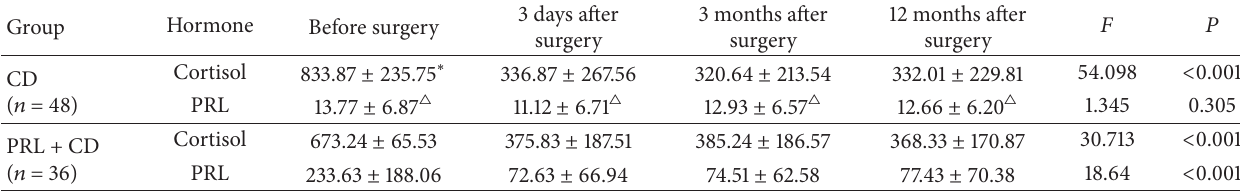
Data are expressed as the mean ± SD. ∗ indicates a significant difference in the cortisol level between the two groups at the same time point ( P < 0.05). △ indicates a significant difference in the PRL level between the two groups at the same time point ( P < 0.05). Each P value shown in the Table is for comparative analysis, within the CD or PRL + CD group, between values before surgery and those 3 days after surgery.